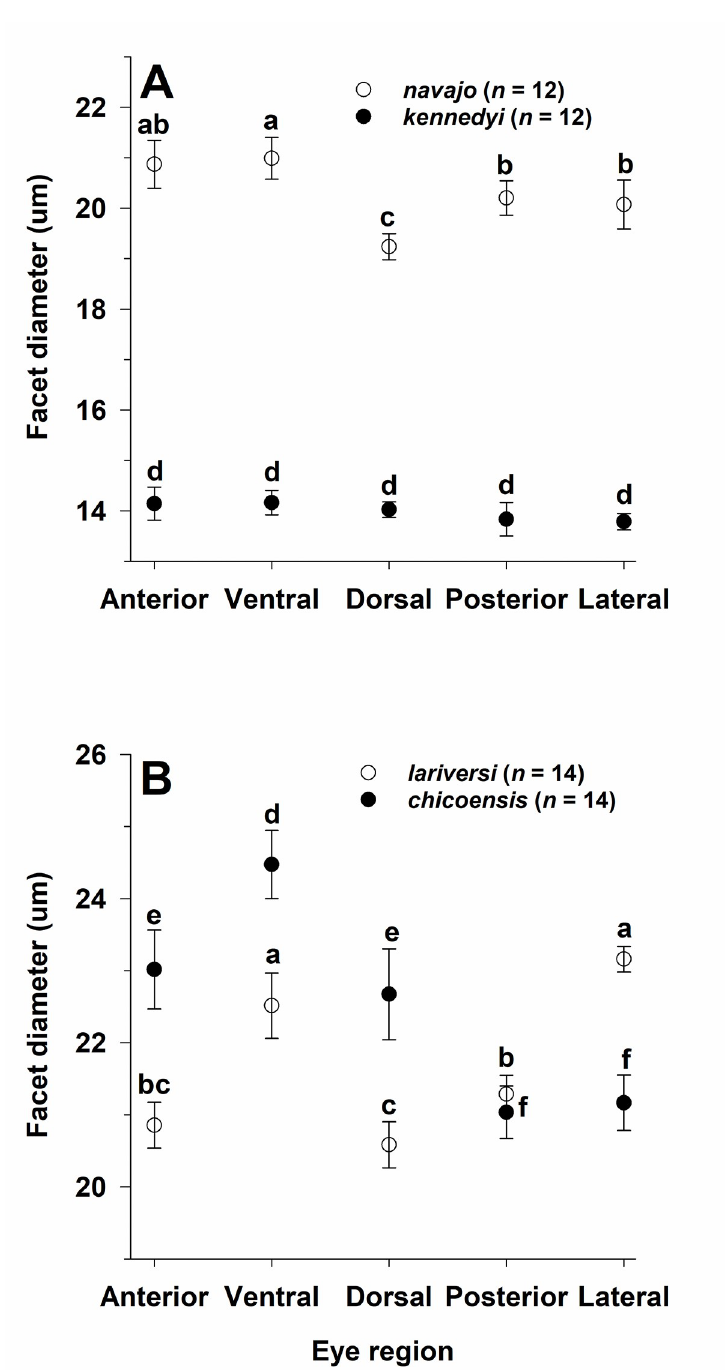
Fig 13. Regional variation in facet diameter for one pale (open circles and regular font) and one dark (filled circles and bold font) (see text) species in each of two ant genera: (A) Myrmecocystus and ( B ) Veromessor . Significant differences within each species are denoted by the letters a – c : a > b > c for pale species; d – f : d > e > f for dark species. Groupings for each species are based on a repeated-measures ANOVA followed by a least significant differences test. Sample size is given after each species